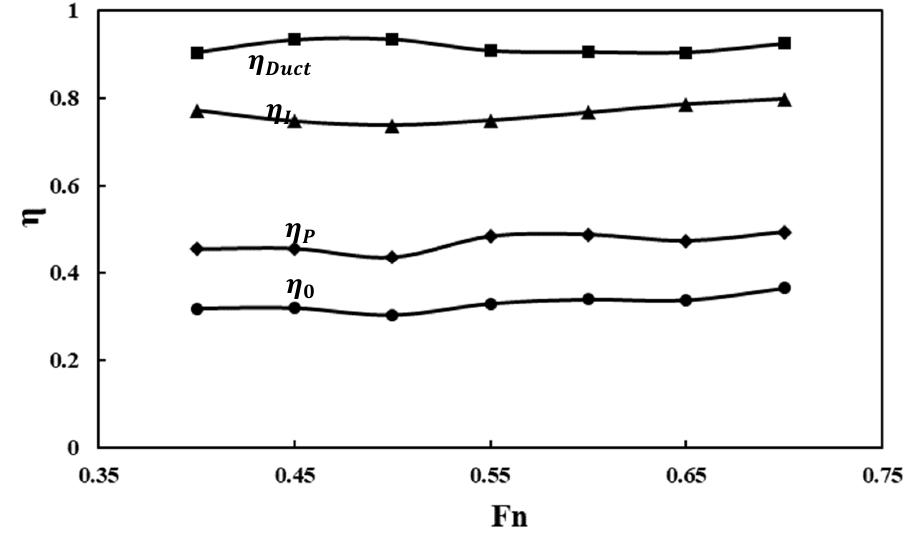
Figure 29. The results of free stream efficiency.